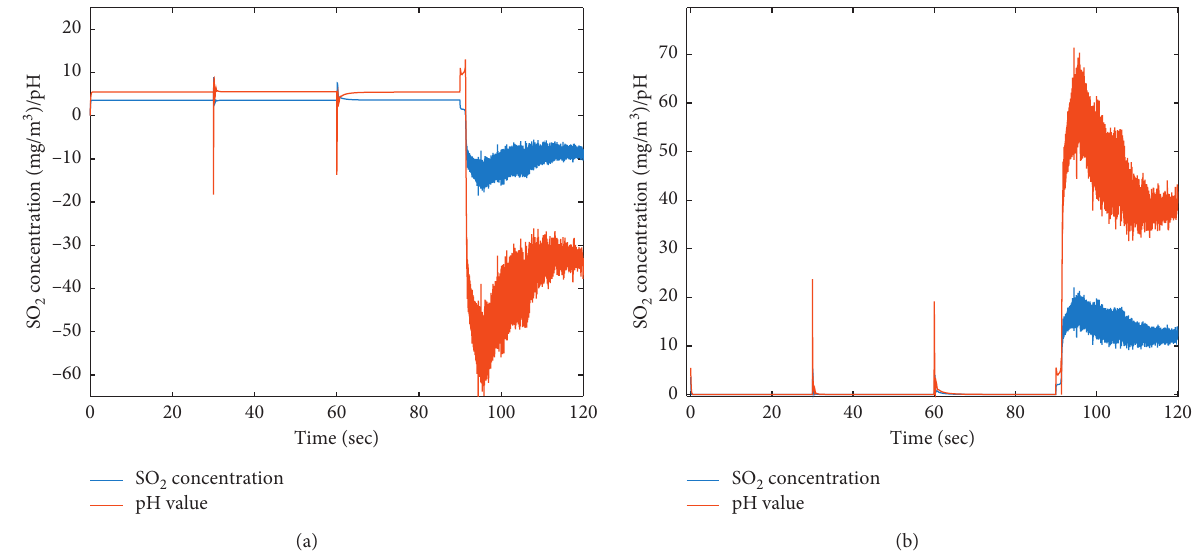
Figure 10: Control response of Case 1: (a) system outputs; (b) absolute value of the control error.